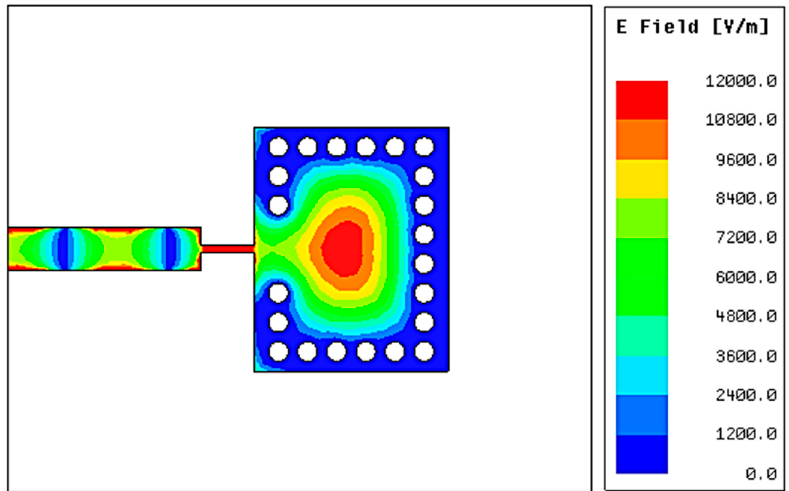
Figure 2. Electric field distribution of a SIW cavity resonator.